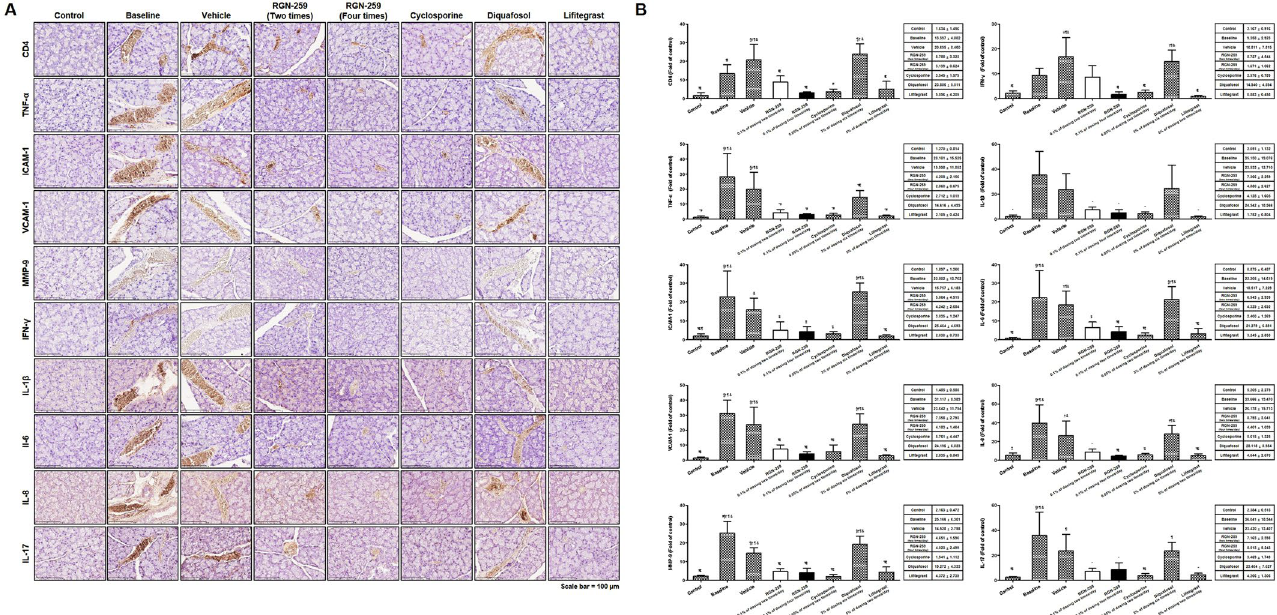
Figure 7. RGN-259 reduced the expression of inflammatory factors comparable to that of CsA and LFA. ( A ) Immunohistochemistry for inflammatory factors in the lacrimal glands of mice. Scale bar = 100 μ m. ( B ) The quantitative expression of inflammatory factors. * P < 0.05 vs. the corresponding value in the baseline desiccation stressed group. # P < 0.05 vs. the value in the vehicle-treated group. § P < 0.05 vs. the value in the RGN-259, 2 times per day group. † P < 0.05 vs. the value in the RGN-259, 4 times per day group. ¶ P < 0.05 vs. the value in the CsA group. ‡ P < 0.05 vs. the value in the DQSl group. & P < 0.05 vs. the value in the LFA